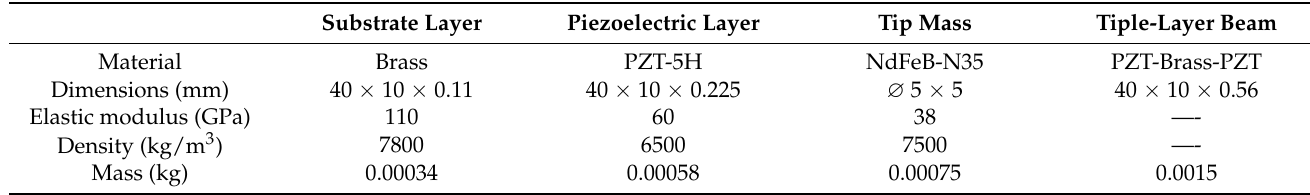
Table 1. Parameters of employed CTLPH sample in the